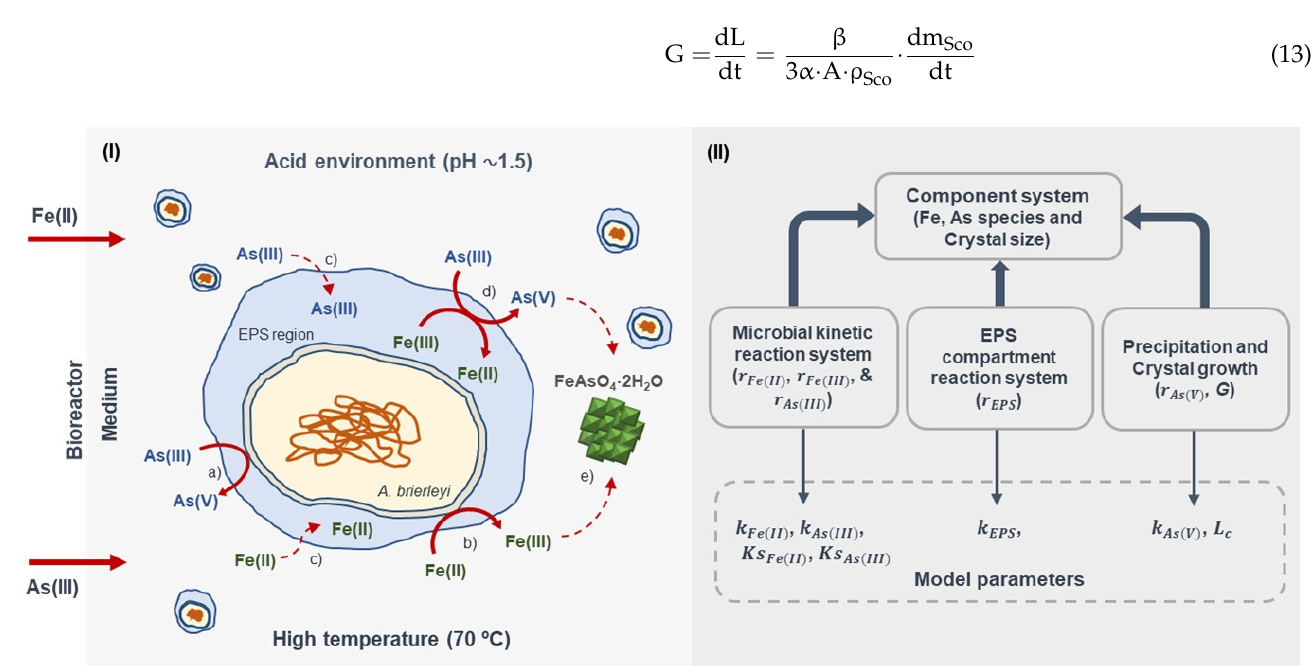
Figure 1. ( I ) Schematic representation of the possible phenomena involved in the bioscorodite formation [9]: (a) microbial As(III) oxidation, (b) microbial Fe(II) oxidation, (c) ions concentrated in the EPS region, (d) oxidation/reduction reactions in the EPS region, and (e) bioscorodite crystallization. ( II ) Modeling approach for modeling the simultaneous processes for bioscorodite formation.